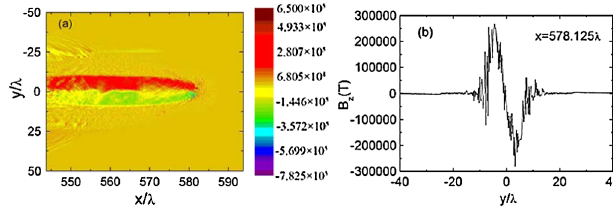
FIG. 5. (Color) (a) Simulation results at t ¼ 600 T for the quasi- static self-generated magnetic field B z for the case of a linearly polarized laser pulse. (b) Distribution of the magnetic field B z at x ¼ 578 : 125 (cid:3) at t ¼ 600 T